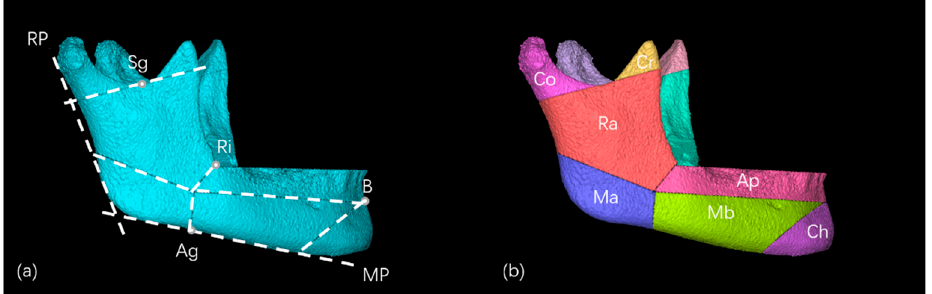
Figure 4. ( a ) The landmarks were used to delimitate the mandibular functional units. Sg, the deepest point on the sigmoid notch; B, supramental, the most concave point on mandibular symphysis; Ri, ramus inflexion, the transition between the front edge of mandibular ramus and the mandibular body; Ag, the highest point in antegonial notch; MP, mandibular plane, the tangent to the lower edge of the mandible; RP ramal plane, the tangent to the condylar process and mandibular ramus. ( b ) The functional mandibular units were reconstructed. Co, condylar process; Cr, coronoid process; Ra, mandibular ramus; Ma, mandibular angle; Ap, alveolar process; Mb, mandibular body; Ch, chin